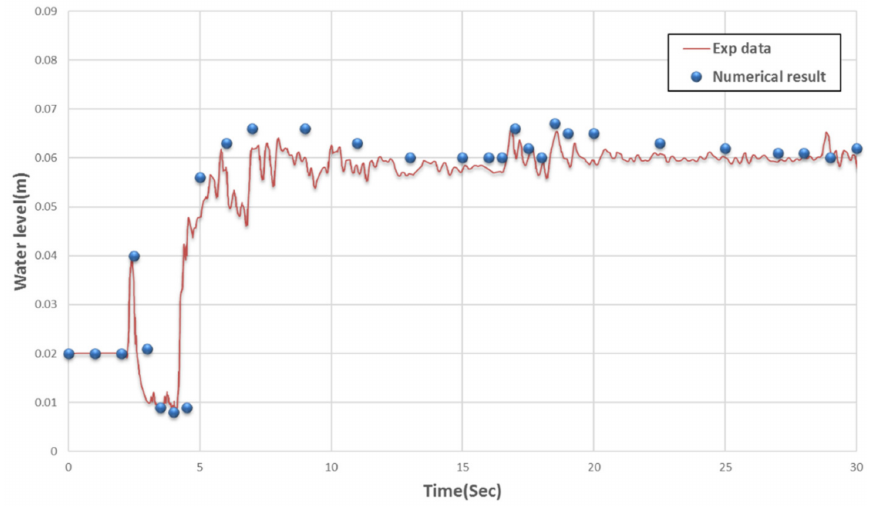
Figure 7. Water level variations at the station of G 2 during the 30 s after dam